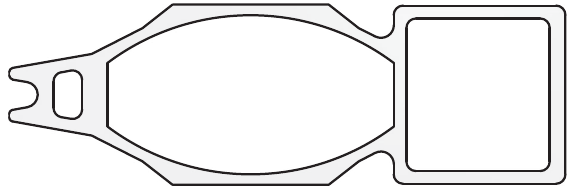
FIG. 13. CesrTA beam pipe cross-section. The vacuum cham- ber (middle) is 9 cm wide and 5 cm high. The cooling water chamber (left) and pump chamber (right) were not part of the